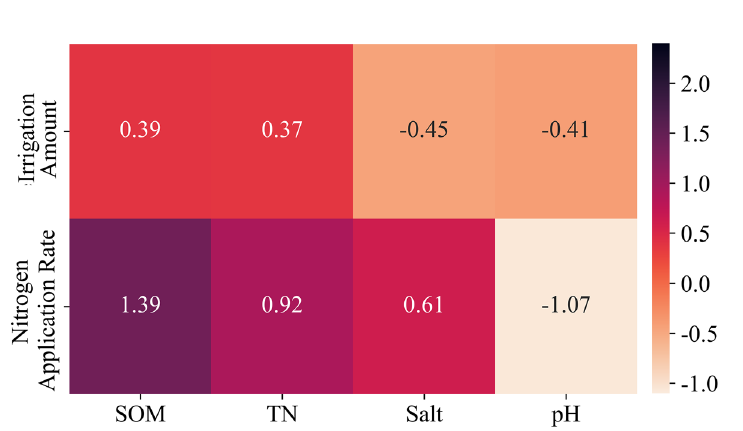
Figure 6. PV normal between production behavior factors and natural factors. Since soil depth, days, irrigation amount and N rate were all artificially set variables, and there was no objective correlation in the data set. Therefore, the preference values among these variables were default e =